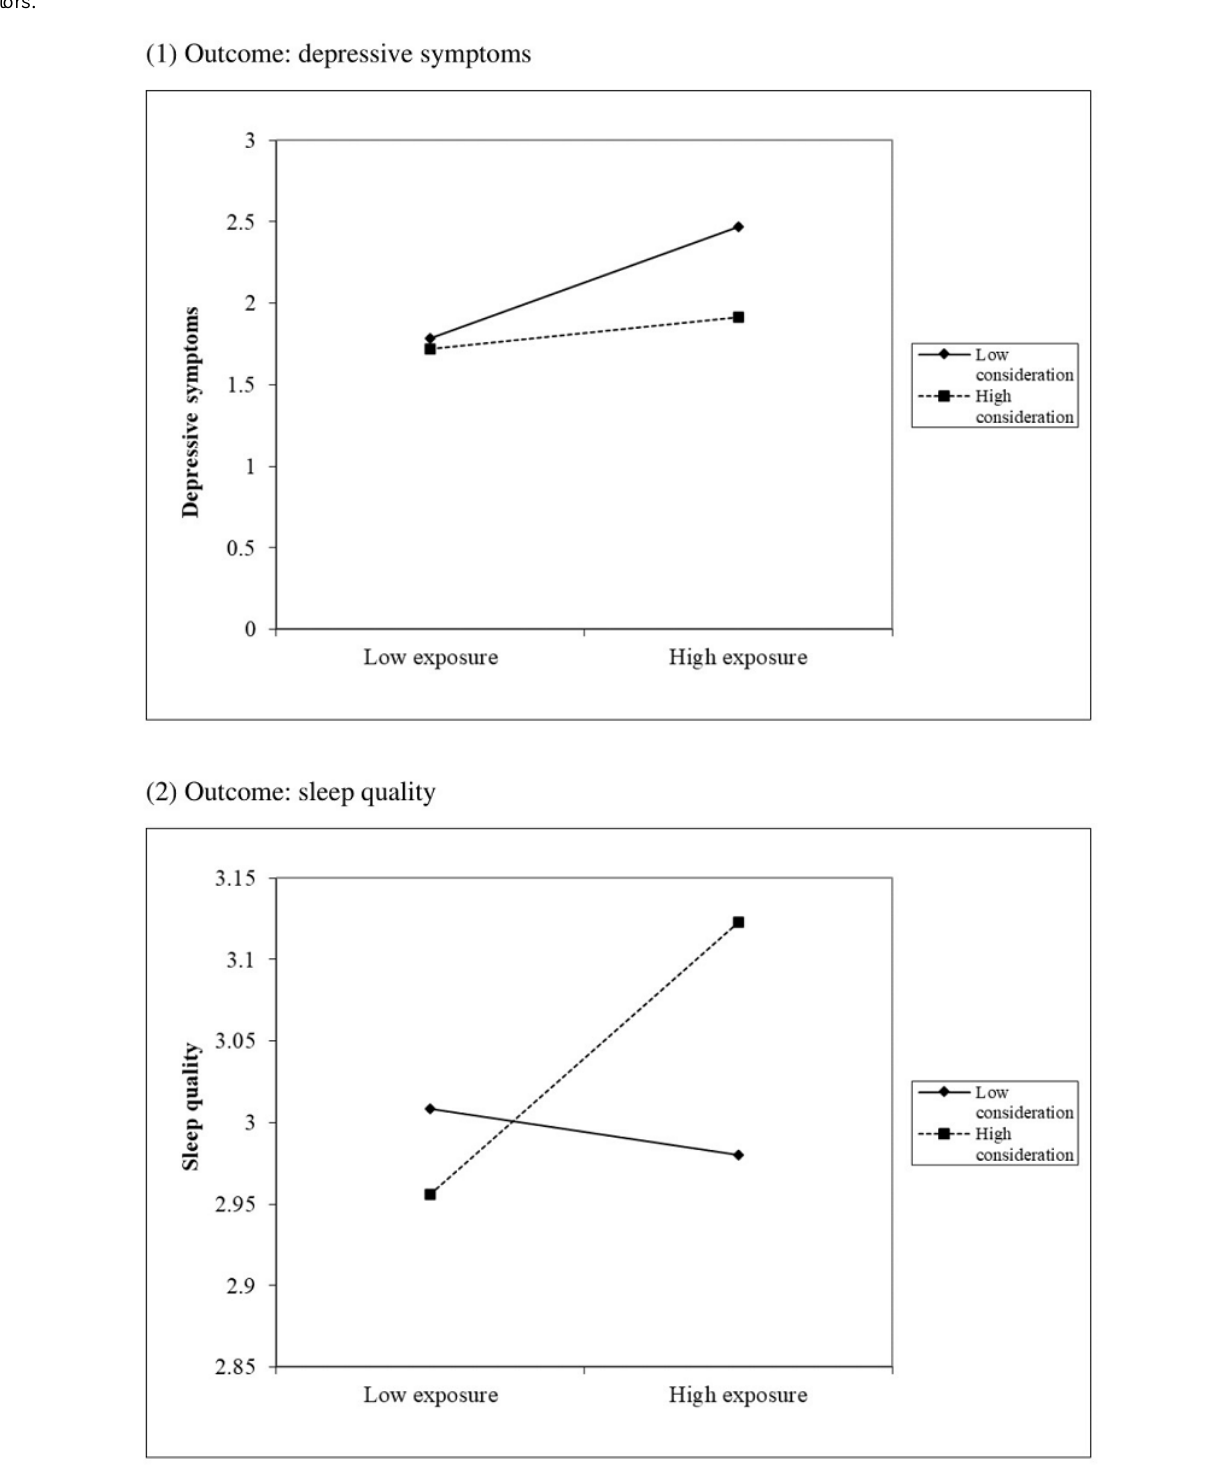
Figure 2. The moderation effects of thoughtful consideration about the veracity of COVID-19–specific information on associations between overall information exposure and the mental health outcomes of (1) depressive symptoms and (2) sleep quality with adjustment for significant background